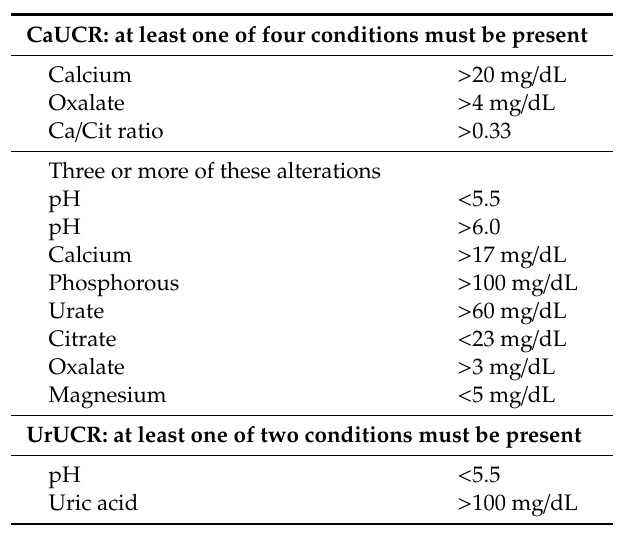
Table 1. Criteria used to define high calcium salt urinary crystallization risk (CaUCR) and high uric acid urinary crystallization risk (UrUCR), based on